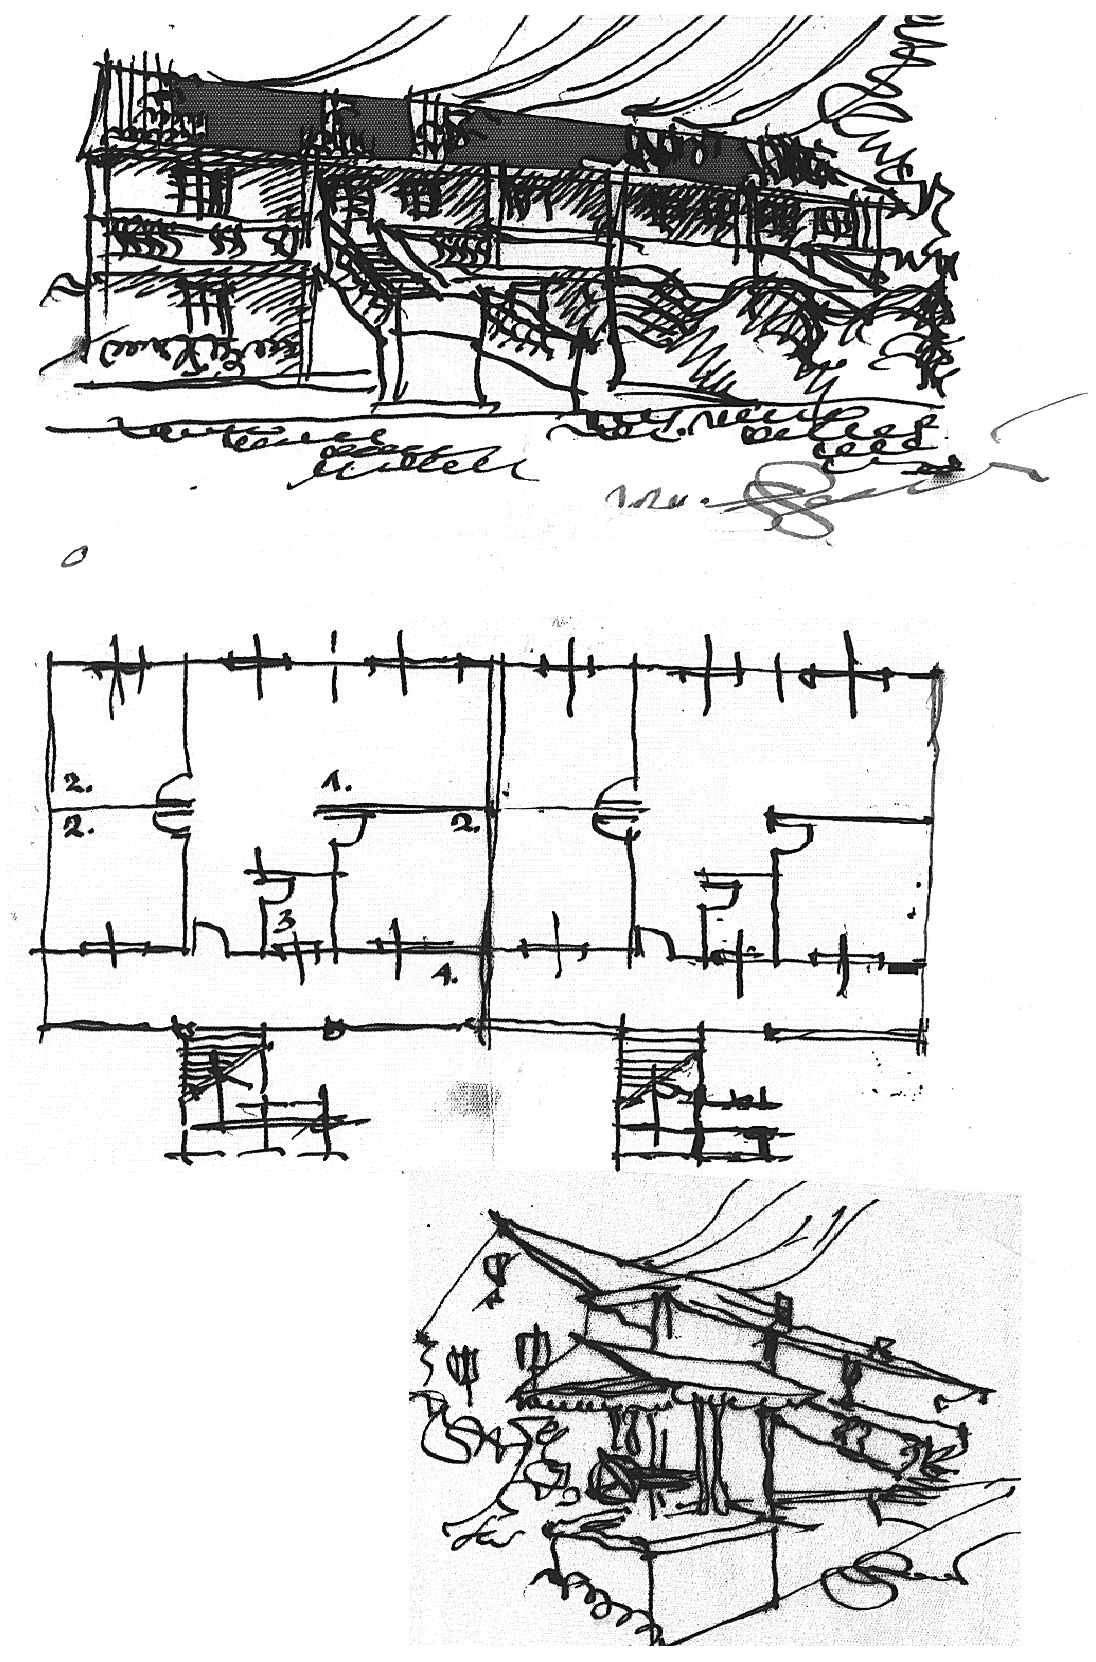
Figure 13. Drawing of the House of Skataric, Zeta region, Montenegro (S. G. Popovic).